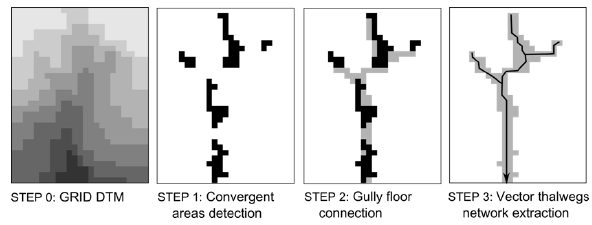
Figure 1. A three-step method to extract a thalweg network from a grid DTM. 2 3 Fig. 1. A three-step method to extract a thalweg network from a grid DTM.